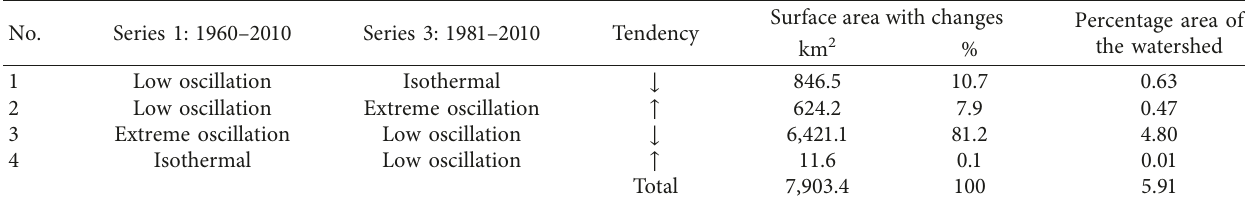
Table 4: Absolute, relative, and proportional areas of the Lerma-Chapala-Santiago watershed with changes in thermal oscillation between time series one (1960–2010) and time series three (1960–1989).